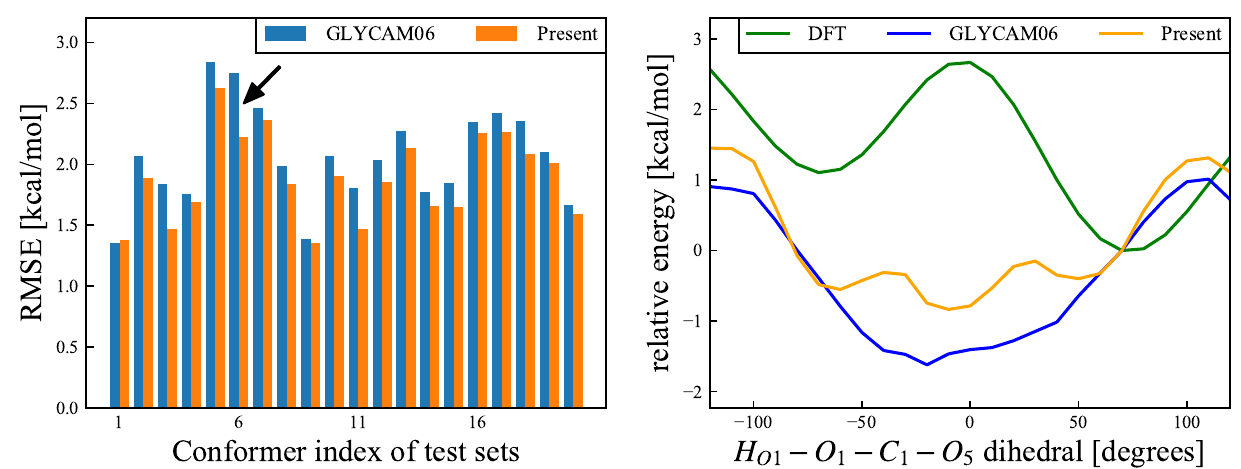
Figure 8. ( Left ): RMSEs (Equation (17)) for O 1 – C 1 rotational deformation modes, for each of the 20 structures. Blue and orange bars refer to the results calculated using the GLYCAM06 force field and our proposed force field, respectively. The black arrow refers to the structure with the most improved RMSE, and the energy change of this structure is shown in the right panel. The average RMSE values for the 20 structures were 2.058 kcal/mol for the GLYCAM06 force field and 1.886 kcal/mol for the present force field. ( Right ): Relative energy change for the structure with the most improved RMSE as an example. The abscissa shows the H O 1 – O 1 – C 1 – O 5 dihedral angle, and the ordinate shows the relative energies for the DFT calculations and MM calculations, for the two different force fields. The reference structure was the most stable structure according to the DFT calculations. The green, blue, and orange curves show the relative energies for the DFT calculations, the GLYCAM06 force field, and our proposed force field,